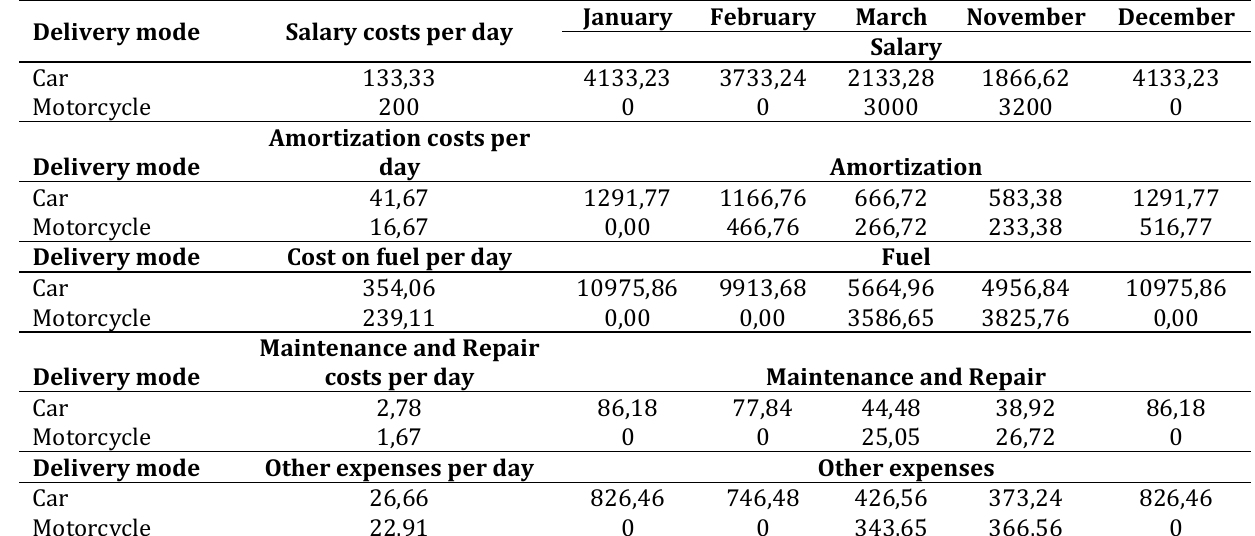
Table 6: Internal costs of combination “Car+Motorcycle” for season with difficult weather conditions Delivery